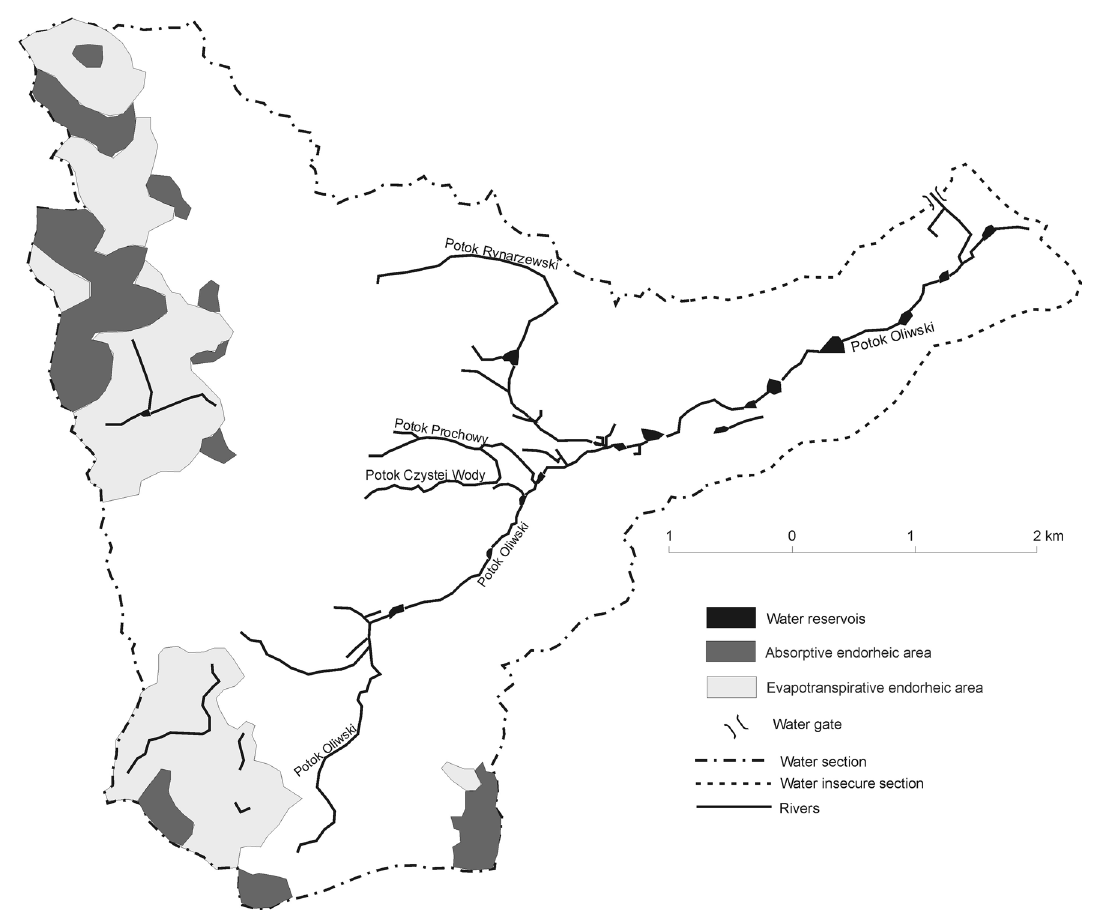
Fig. 4 Potok Oliwski catchment (Major and Cieśliński